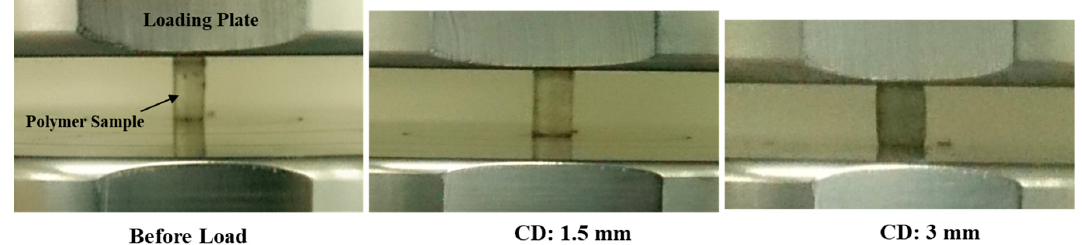
Figure 8. Structural deformation of the Bis-GMA polymer specimen under different compressive deformation (CD).